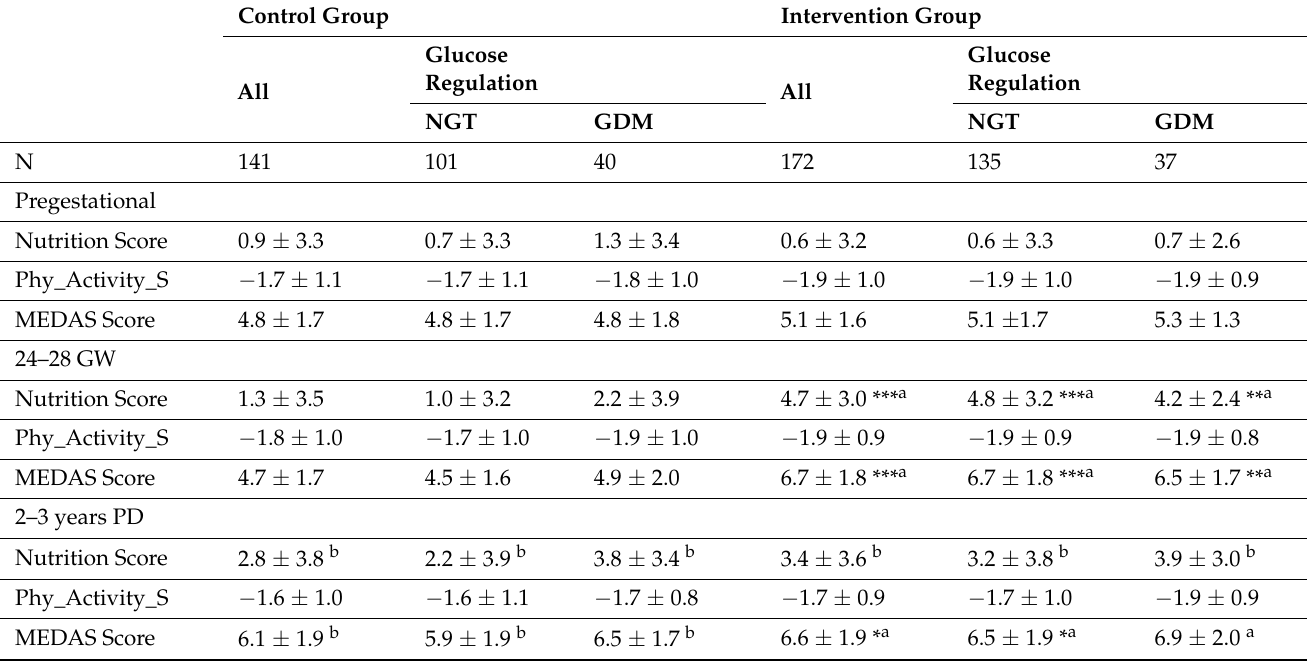
Table 3. Lifestyle pattern during gestation and at 2–3 years post-delivery: data by groups and glucose tolerance during